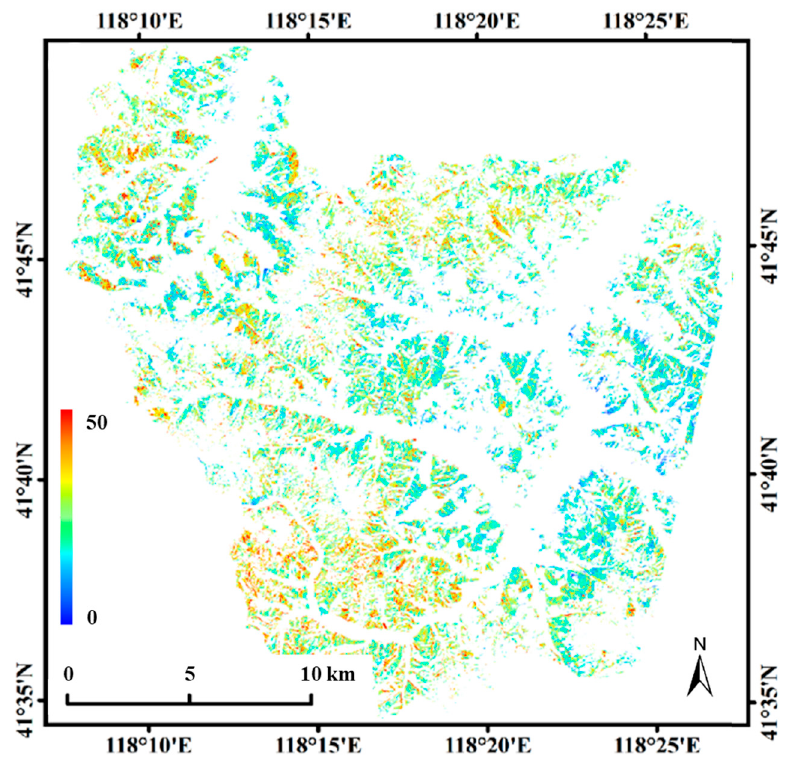
Figure 4. The extracted relative canopy height (m) image of larch plantations.